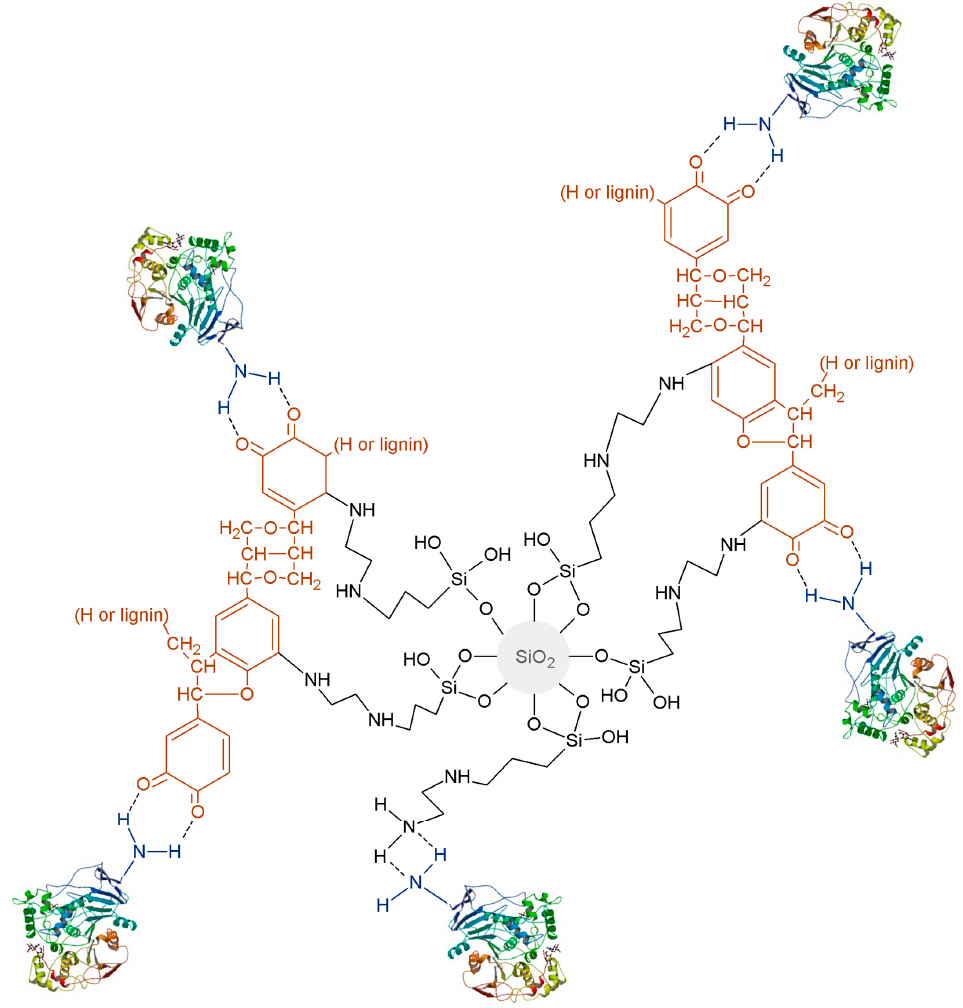
Figure 6. Proposed mechanism for the attachment of lipase B from Candida antarctica to the surface of the silica ‐ lignin matrix.